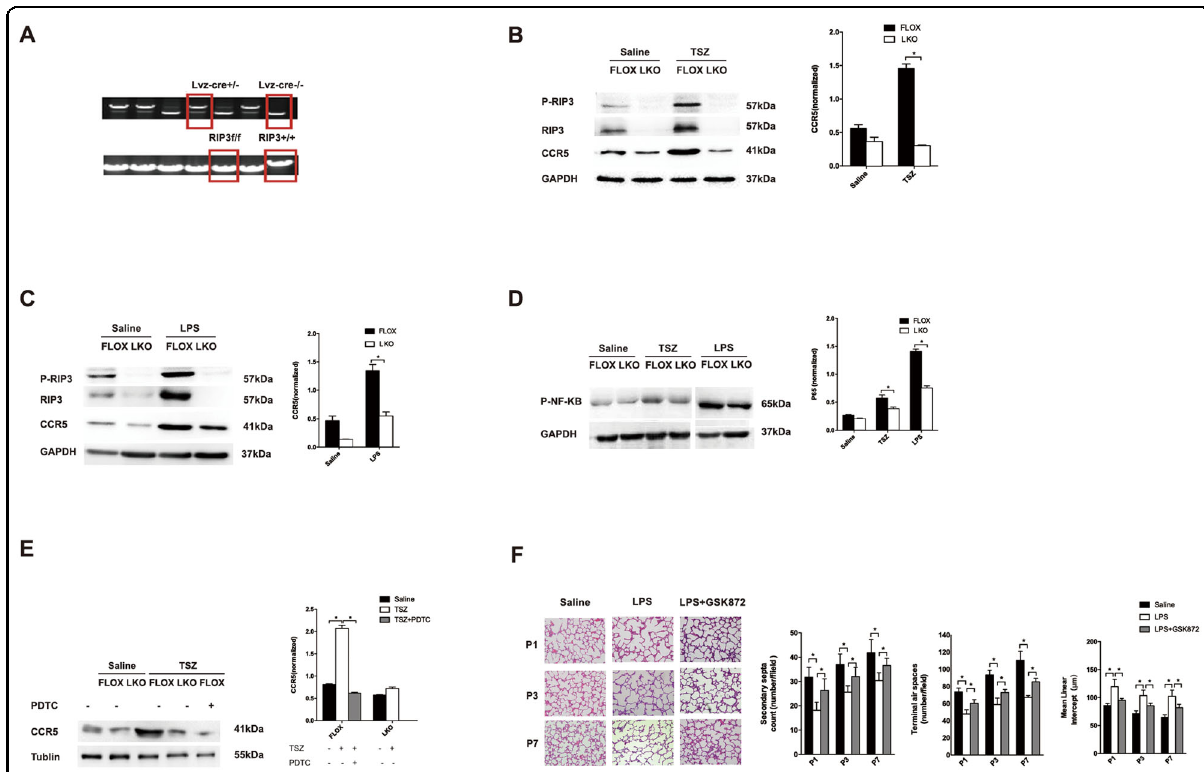
Fig. 6 RIP3 regulates CCR5 through NF-kB. A Genotyping of Rip3LKO mice. B Representative immunoblot probed for CCR5 in whole BMDM lysate from Rip3LKO stimulated with TSZ (20 ng/mL TNF- α , 100 nM smac minmetic, 20 μ M zVAD) for 16 h and corresponding quanti fi ed data. Data are expressed as mean ± SD ( n = 6), * p < 0.05. C Representative immunoblot probed for CCR5 in BMDM lysates from Rip3LKO mice stimulated with LPS (1 μ g/mL) for 16 h and corresponding quanti fi ed data. Data are expressed as mean ± SD ( n = 6), * p < 0.05. D Representative immunoblot probed for NF-kB in BMDM lysate from Rip3LKO mice stimulated with TSZ or LPS at the indicated conditions for 16 h and the corresponding quanti fi ed data. Data are expressed as mean ± SD ( n = 6), * p < 0.05. E Representative immunoblot probed for CCR5 in BMDM lysate from Rip3LKO mice stimulated with TSZ at the indicated condition and PDTC (50 μ M) for 16 h and the corresponding quanti fi ed data. Data are expressed as mean ± SD ( n = 6), * p < 0.05. F Representative lung sections stained with H&E. Scale bar: 50 μ m. Quanti fi cation of the terminal airspace, secondary septa, and MLI of lung tissues from P1, P3, and P7 treated with LPS and GSK872. Data are expressed as mean ± SD ( n = 6), * p <